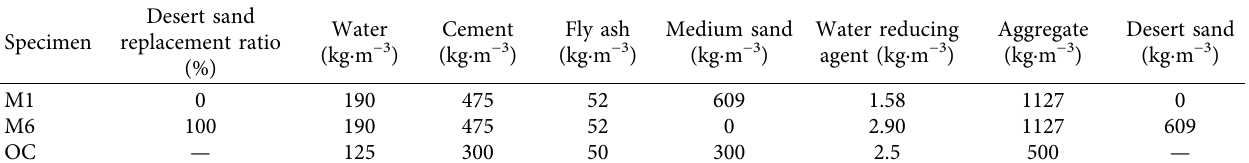
Table 4: Mix ratio of